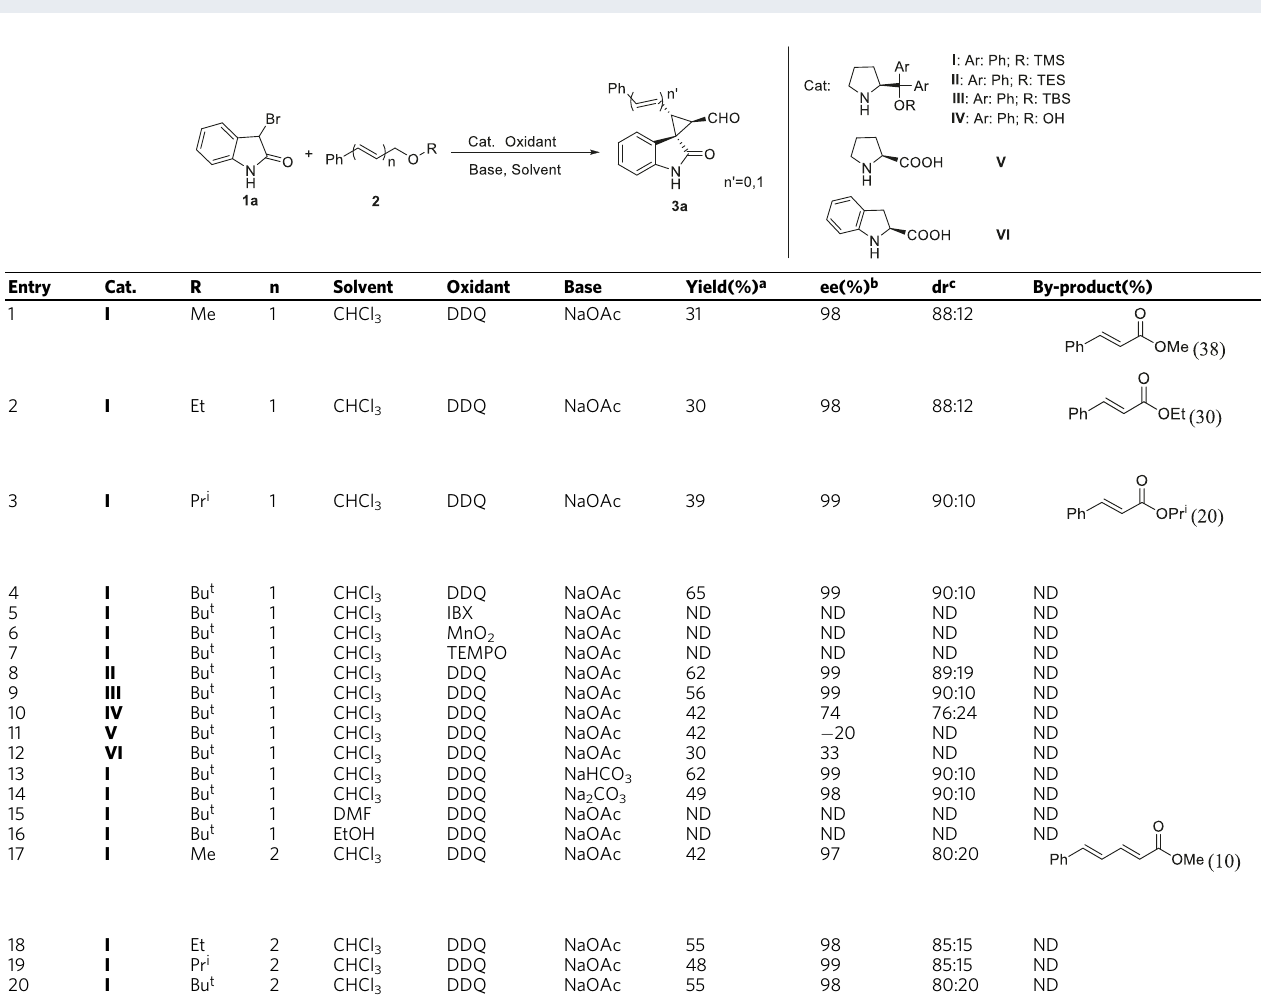
Table 1 Optimization of reaction